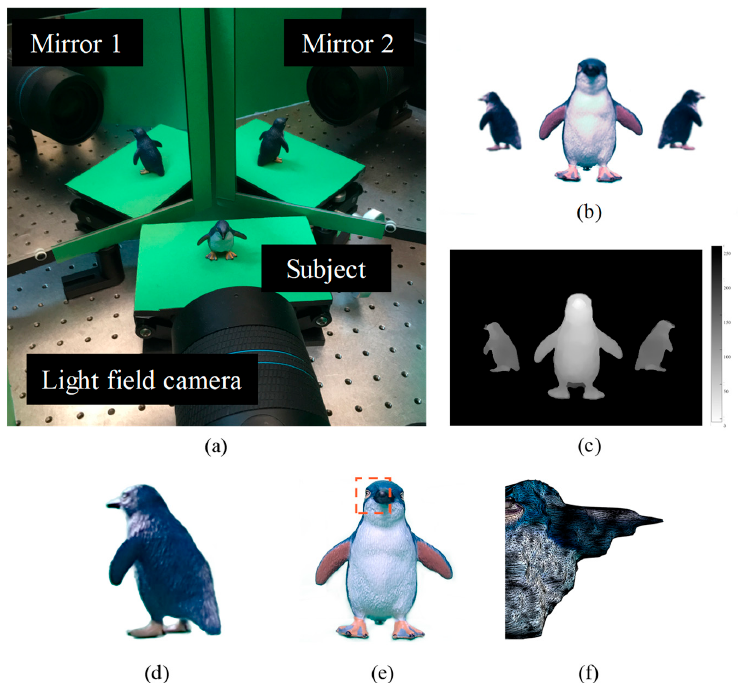
Figure 8. The 360-degree light field capturing setup and experimental results. ( a ) The implemented capturing system with two plane mirrors; ( b ) Captured light field image focused on the center perspective and processed with chroma-key technique; ( c ) The depth map of the light field calculated by the proposed algorithm; ( d ) Refocused image for left perspective; ( e ) Refocused image for center perspective; and, ( f ) Reconstructed mesh with color information.